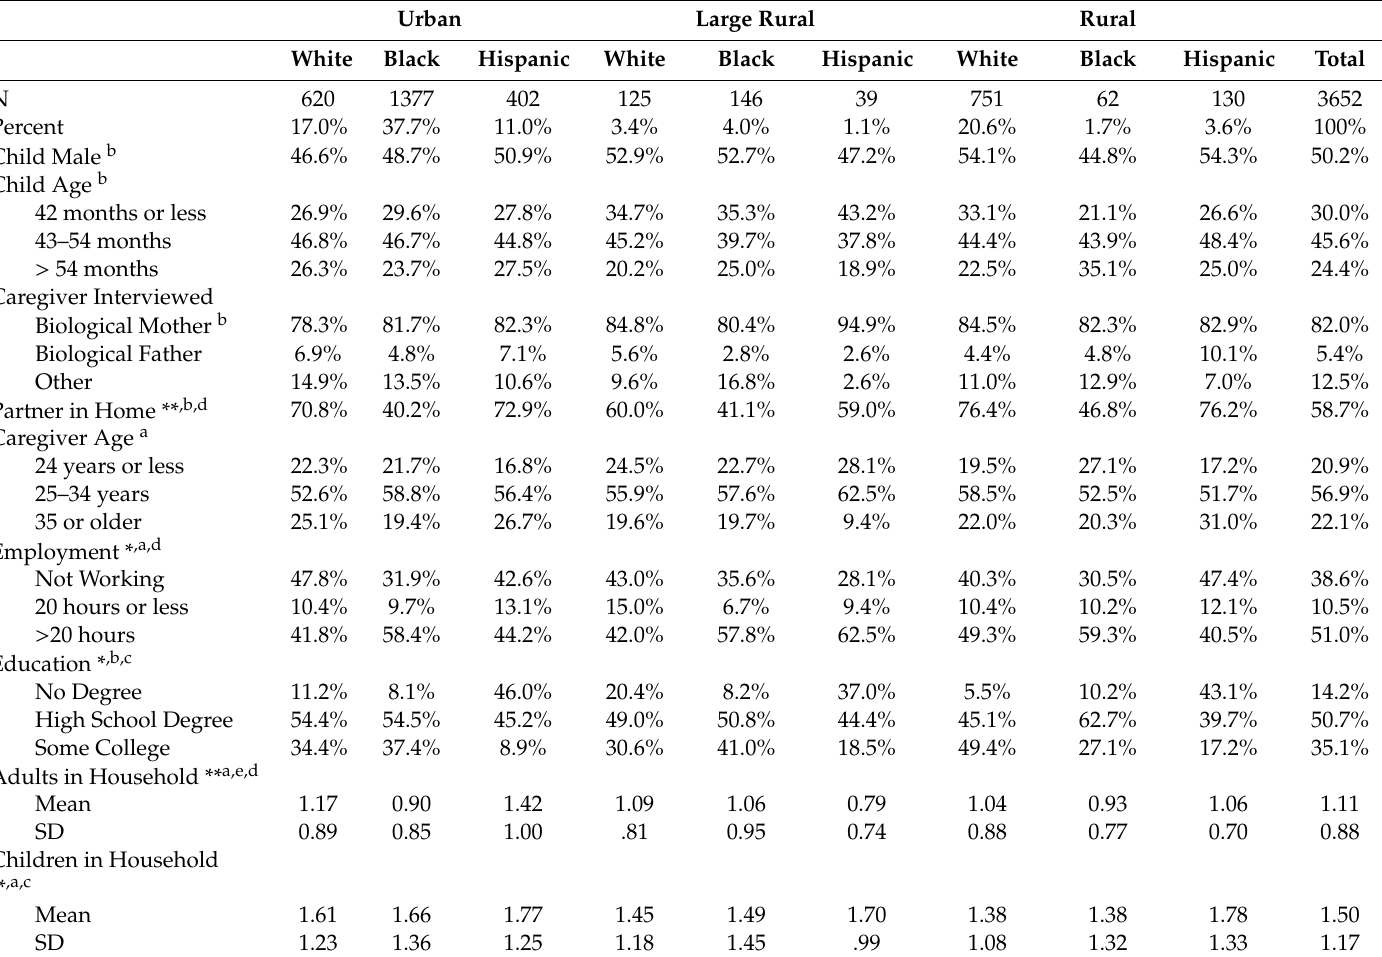
Table 1. Comparisons of characteristics across location and race / ethnicity of